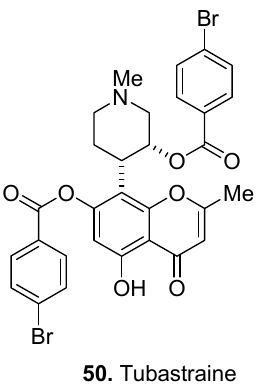
Figure 20. Tubastraine ( 50 ).